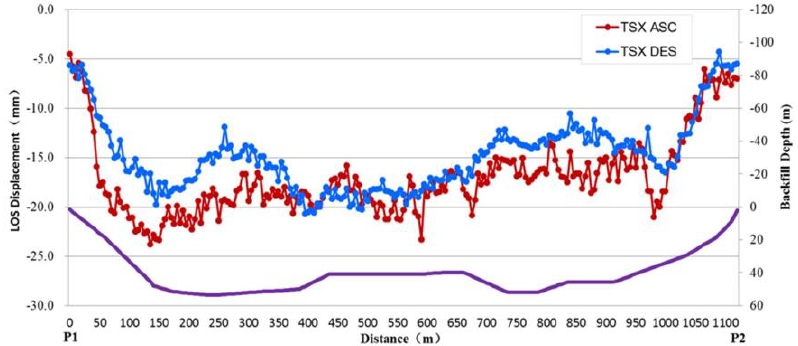
Figure 15. The total settlement on the dam top along the longitudinal section with clay core depth curves by TSXSL.